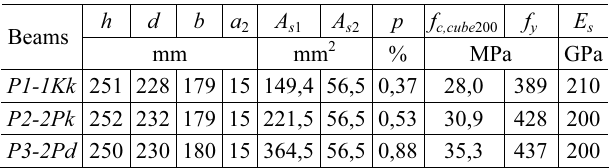
Table 8. Parameters of test beams (Фигаровский [Figarovskij]